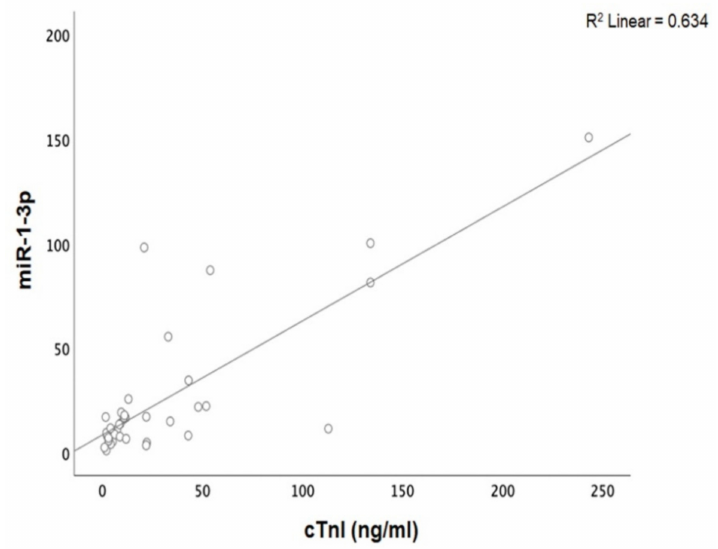
Figure 3. Correlation between cardiac troponin I (cTnI) levels and microRNA-1-3p (miR-1-3p) expression levels (arbitrary units calculated by the (2 − ddCt ) method) levels in patients with acute myocarditis: ( r = 0.79, p < 0.01).